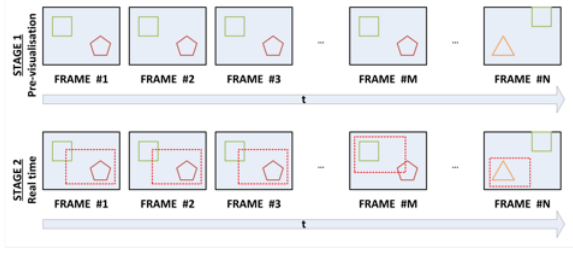
Figure 5. Definition and real-time visualization of video